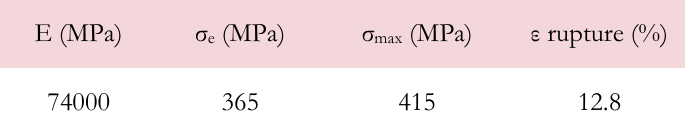
Table 1: Mechanical properties of the aluminum alloy 2024 T351 (AFGROW database).